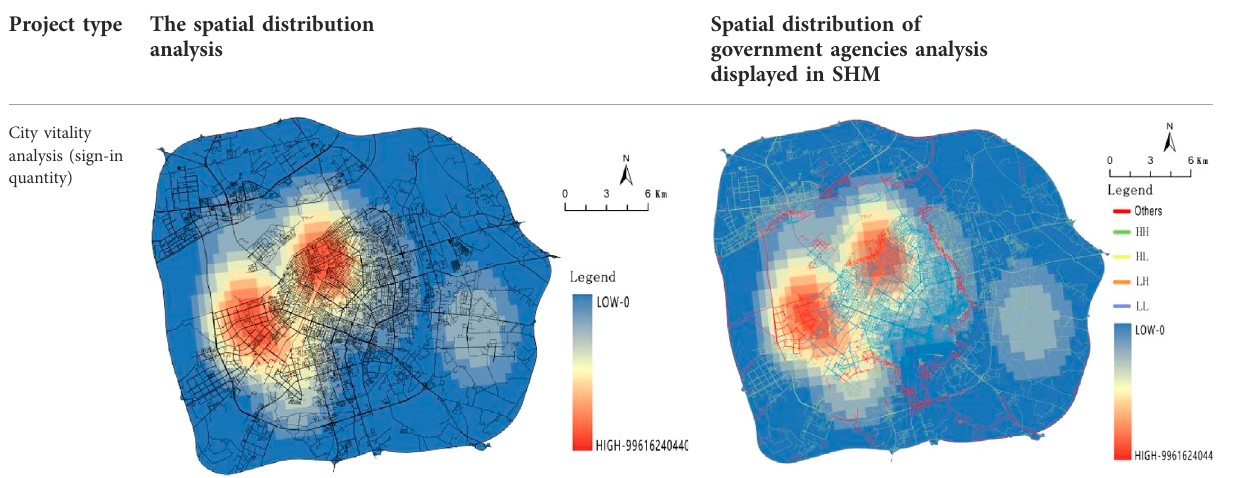
TABLE 11 Spatial distribution of sign-in quantity in